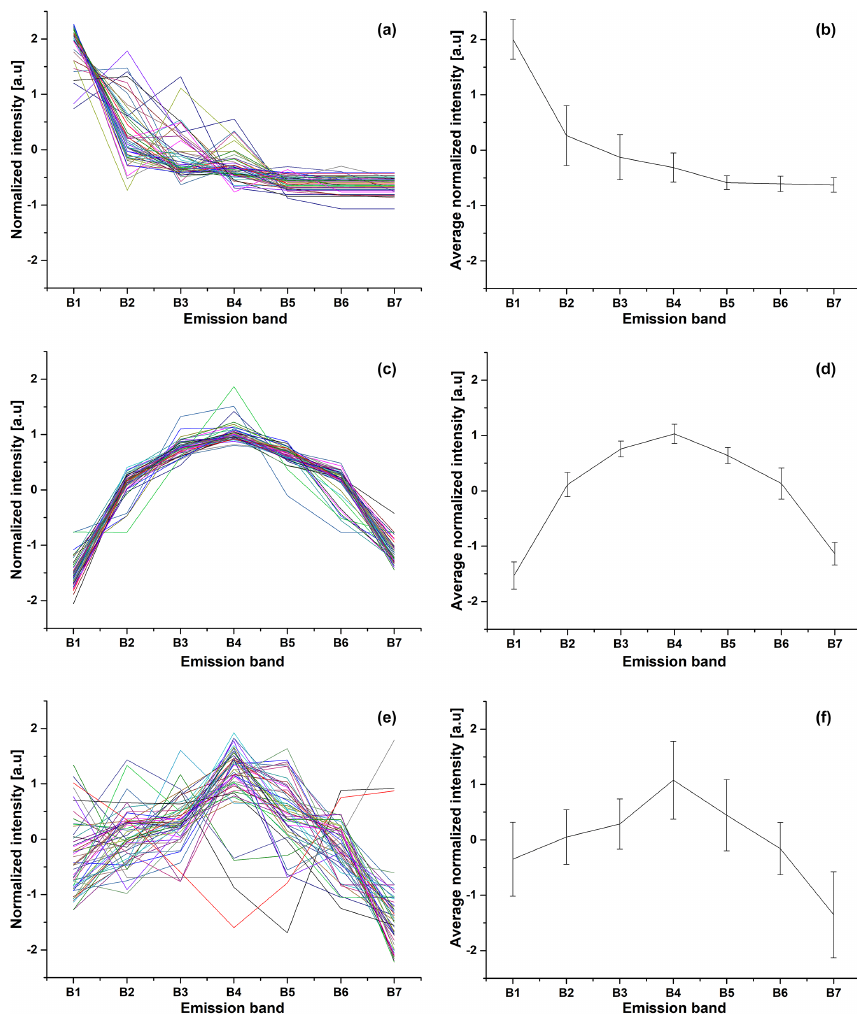
Figure 2. Example of 50 normalized subsequent fluorescence characteristics of NT (a) , FM (c) and LCB (e) and corresponding averaged normalized intensities of NT (b) , FM (d) and LCB (f) . Error bars represent standard deviation of measurements.